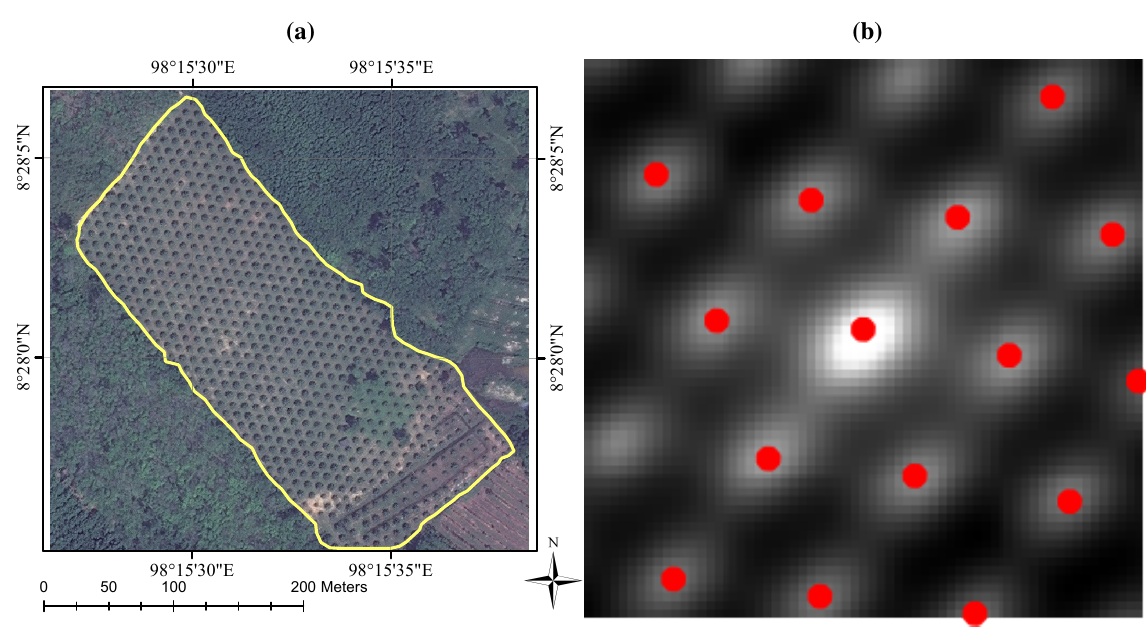
Figure 4. One of the subsets used in the performance evaluation with its semi-variogram. The red dots on the semi-variogram image are the position of the local peaks: ( a ) One of the test data subsets from QuickBird imagery and ( b ) its